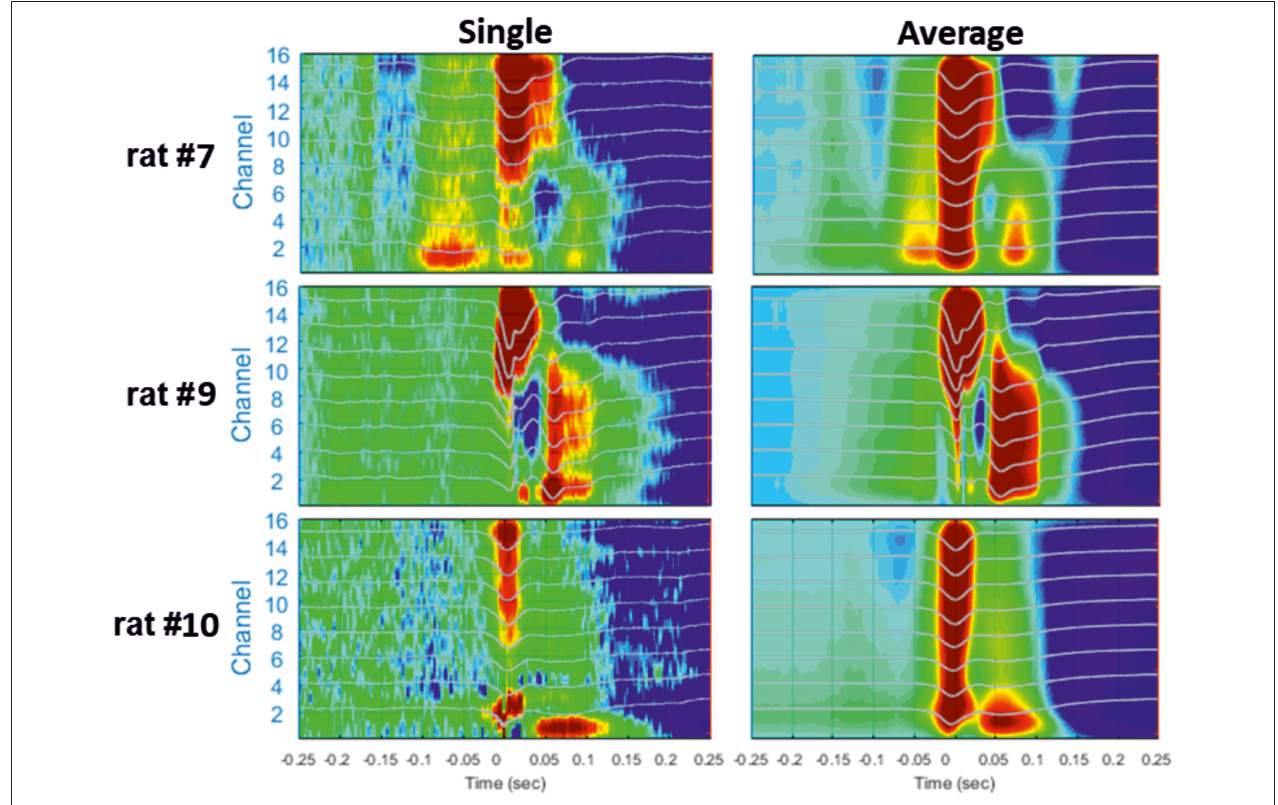
FIGURE 5 | Examples of different CSD analyses of raw signals surrounding a single IIS (Left) and after averaging 200 IISs (Right) . The LFP signals are superimposed on the color maps (TO corresponds to the peak of